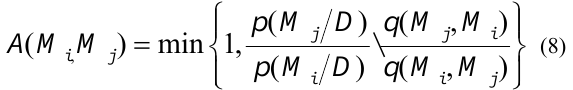
(left), which the buildings consists of. In blue, the primitives are merged into result footprints (middle) and the ground plan is given in green (right). The assessment of the reconstruction is given in Table 1.